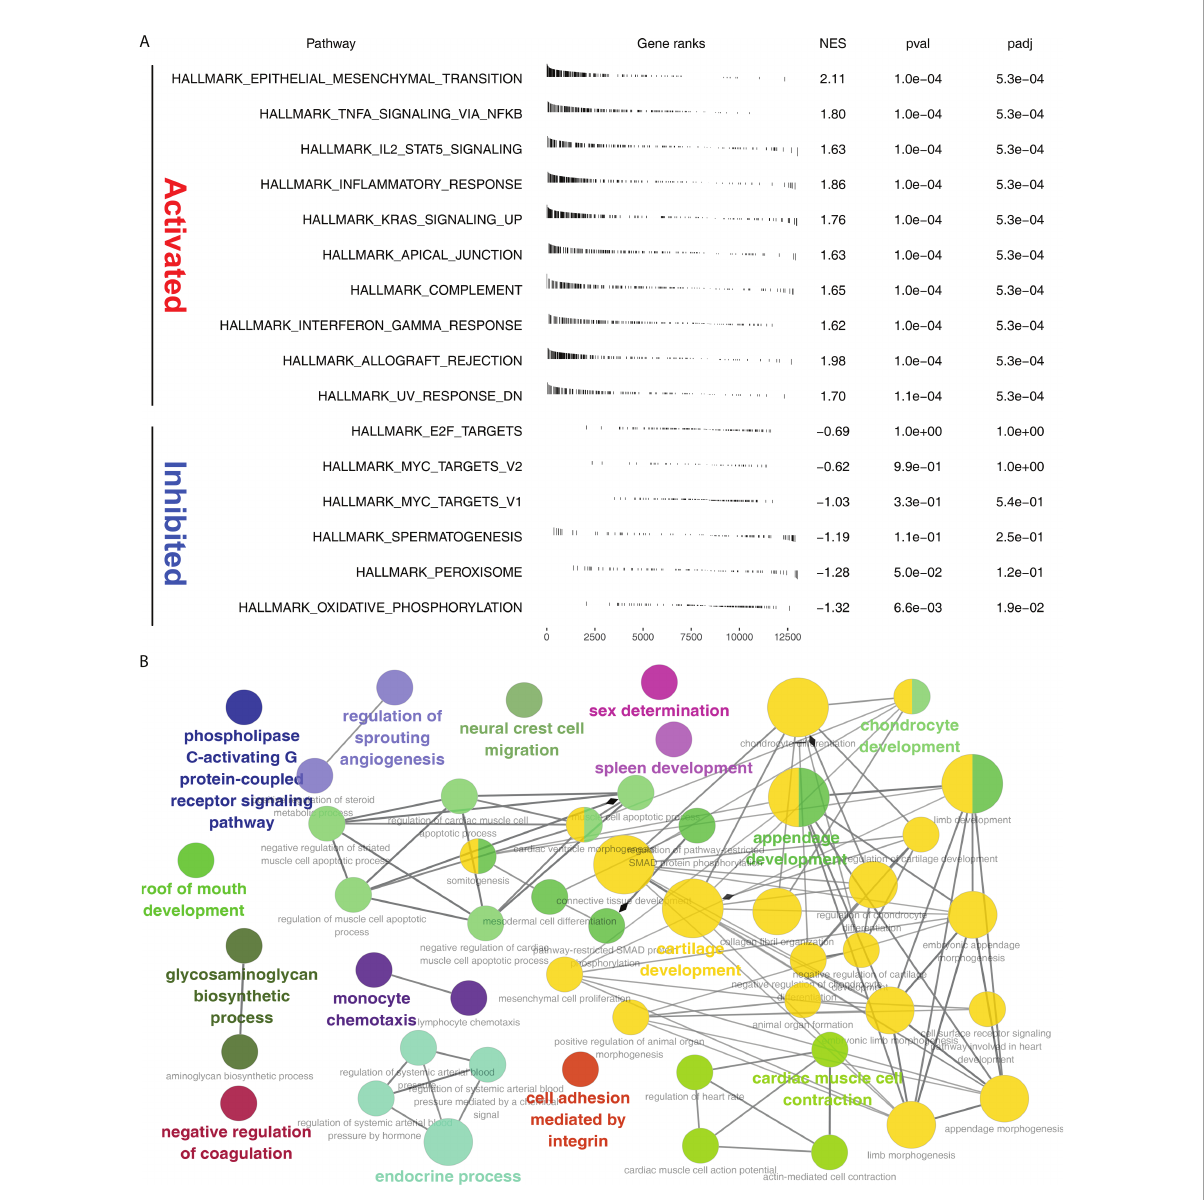
FIGURE 5 Pathway enrichment analysis. (A) GSEA analysis of Cluster2 based on the Hallmark gene set; (B) ClueGO analysis in Cytoscape